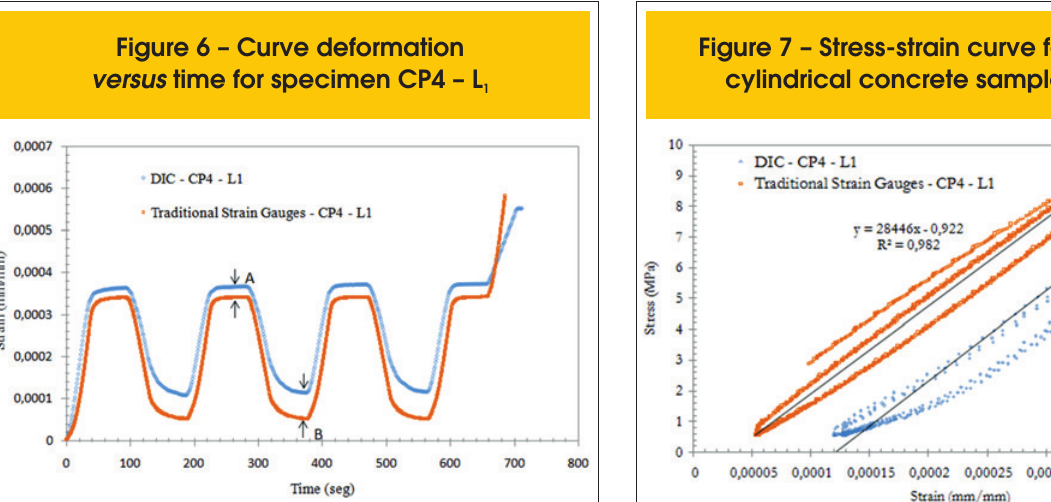
Figure 7 – Stress-strain curve for a 28-day cylindrical concrete sample CP4 – L 1